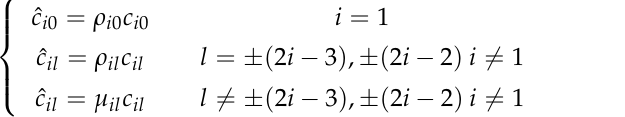
Figure 2. Sub-band distribution.